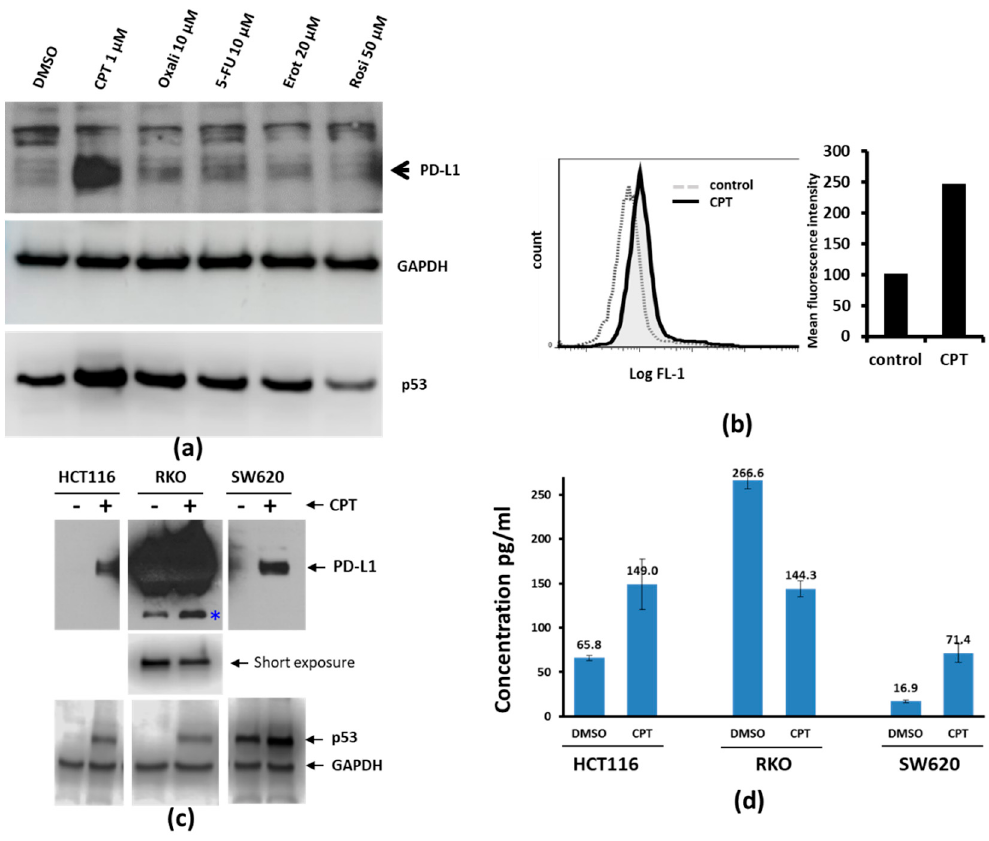
Figure 1. Camptothecin (CPT) treatment increases the expression of PD-L1. ( a ) SW620 colon cancer cells were treated with either vehicle or the indicated drugs for 24 h. Cell lysates were probed for the expression of Programmed Death-Ligand 1 (PD-L1) and p53. GAPDH was probed to compare the total protein loaded on the gel. Among the compounds tested under these experimental conditions, CPT was the best inducer of both PD-L1 and p53. ( b ) PD-L1 detection by flow cytometry. SW620 cells were treated with 1 µ M CPT for 24 h, and the expression of PD-L1 was analyzed by flow cytometry. The solid black line in the left panel indicates the right shift in the fluorescence (FL1) peak, indicating increased expression of PD-L1 compared to control (dashed line). Quantification of the mean relative intensity for PD-L1 in control or CPT-treated SW620 cells is shown in a bar graph (right panel). Numbers below each panel indicate the relative integrated density of the protein band in that lane. ( c ) The three colorectal cancer (CRC) cell lines were treated with 1 µ M CPT for 24 h, and cell lysates were examined for PD-L1 expression. The upper panel shows immunoblots for PD-L1. Due to the high levels of PD-L1 in RKO cells (middle panel), the protein bands were over-exposed. The middle panel shows a brief re-exposure of the PD-L1 immunoblot to show the levels of PD-L1. The lower panel shows immunoblot bands for p53 to indicate drug response and GAPDH for a loading control. * a possible cleavage product of PD-L1 in RKO cells. ( d ) ELISA assay for the determination of PD-L1 response in colon cancer cells. Cell lysates from DMSO- or CPT-treated cells were analyzed for PD-L1 levels by ELISA. HCT116 and SW620 lysates were loaded at 40 µ g total protein per well, whereas 4 µ g total protein was loaded per well for RKO cell lysates. The Y-axis and numbers above the columns of the bar graph indicate concentrations in pg / mL. Lysates were assayed in duplicate. Error bars show the standard variation from the mean.